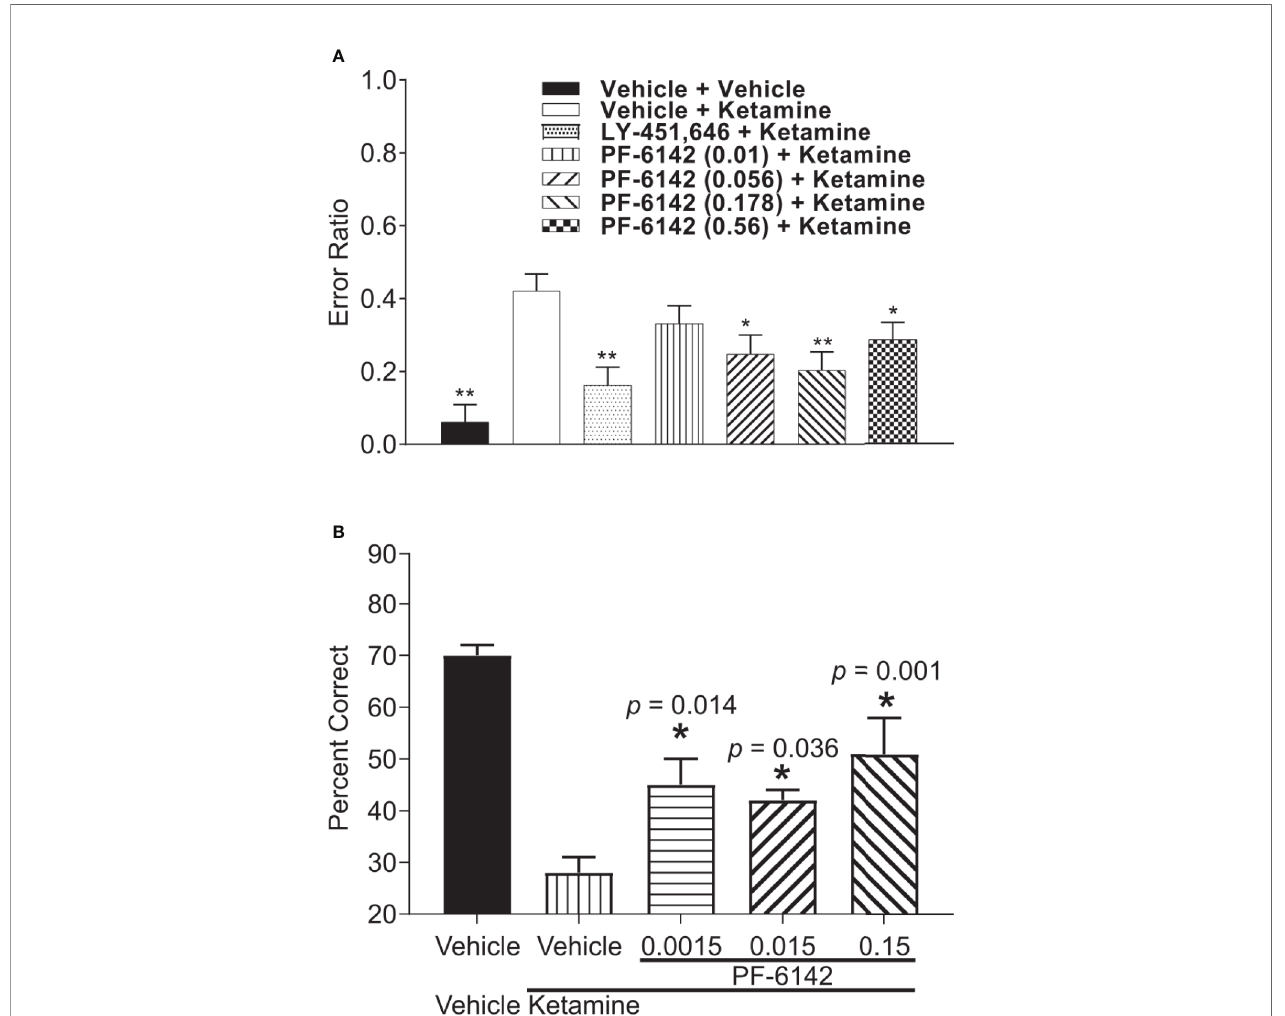
FIGURE 5 | PF-6142 effects on ketamine-induced working memory de fi cits. (A) Pre-treatment with PF-6142 dose-dependently prevents ketamine-induced de fi cits in the rat radial arm maze assay. Data are presented as mean errors + SEM. Kruskal-Wallis test with Dunn ’ s multiple comparison post-test *p < 0.05, **p < 0.01 vs. vehicle + ketamine. N=10 – 21. (B) Treatment with PF-6142 prevents ketamine-induced de fi cits in the non-human primate spatial delayed response task. One-way ANOVA with Dunnett ’ s post-test adjusted *p < 0.05 vs. vehicle + Ketamine and N = 8